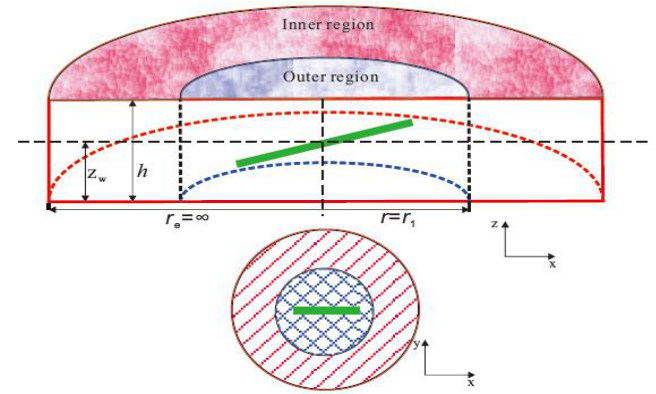
Figure 1. Schematic diagram of highly deviated well in dual-porosity composite gas reservoir.